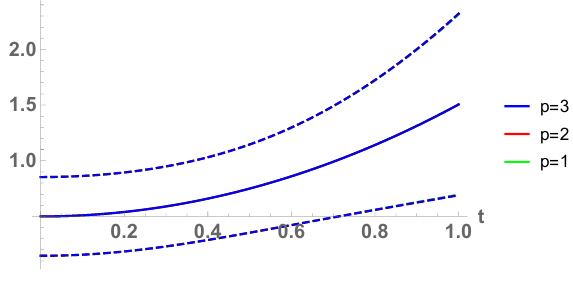
Figure 4: Expectation and confidence interval for the solution stochastic process, for orders of basis p = 1, 2, 3 . Example 4.3, assuming independent random